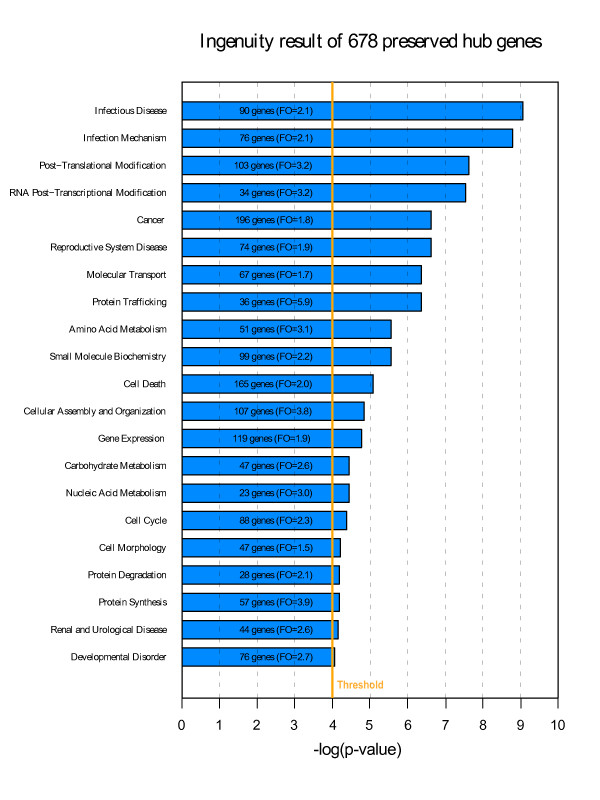
Ingenuity analysis result for 678 preserved hub genes. Functional enrichment analysis of the preserved intramodular hub genes found in CTX, CN or CB data (selected in Figure 5) (678 genes). Only gene categories with significant enrichment p-values are presented. FO (inside brackets) denotes fold overrepresentation (defined as observed counts divided by expected counts under the null hypothesis). To calculate the Fisher's exact p-values and FOs, we use the Ingenuity default background (here all human genes).